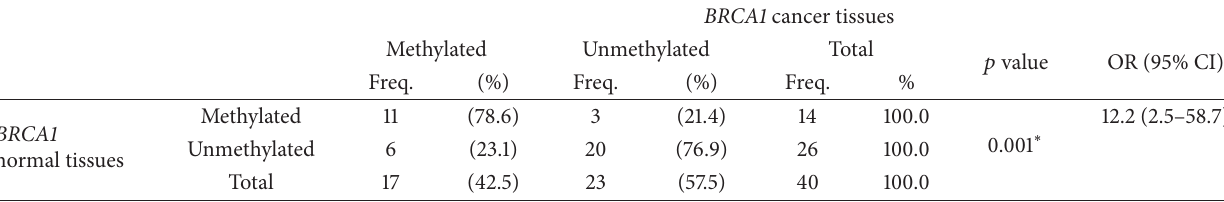
Table 6: Relation between methylation status of BRCA1 promoter in cancer tissue specimens and normal tissue specimens in 40 sporadic breast cancer patients.